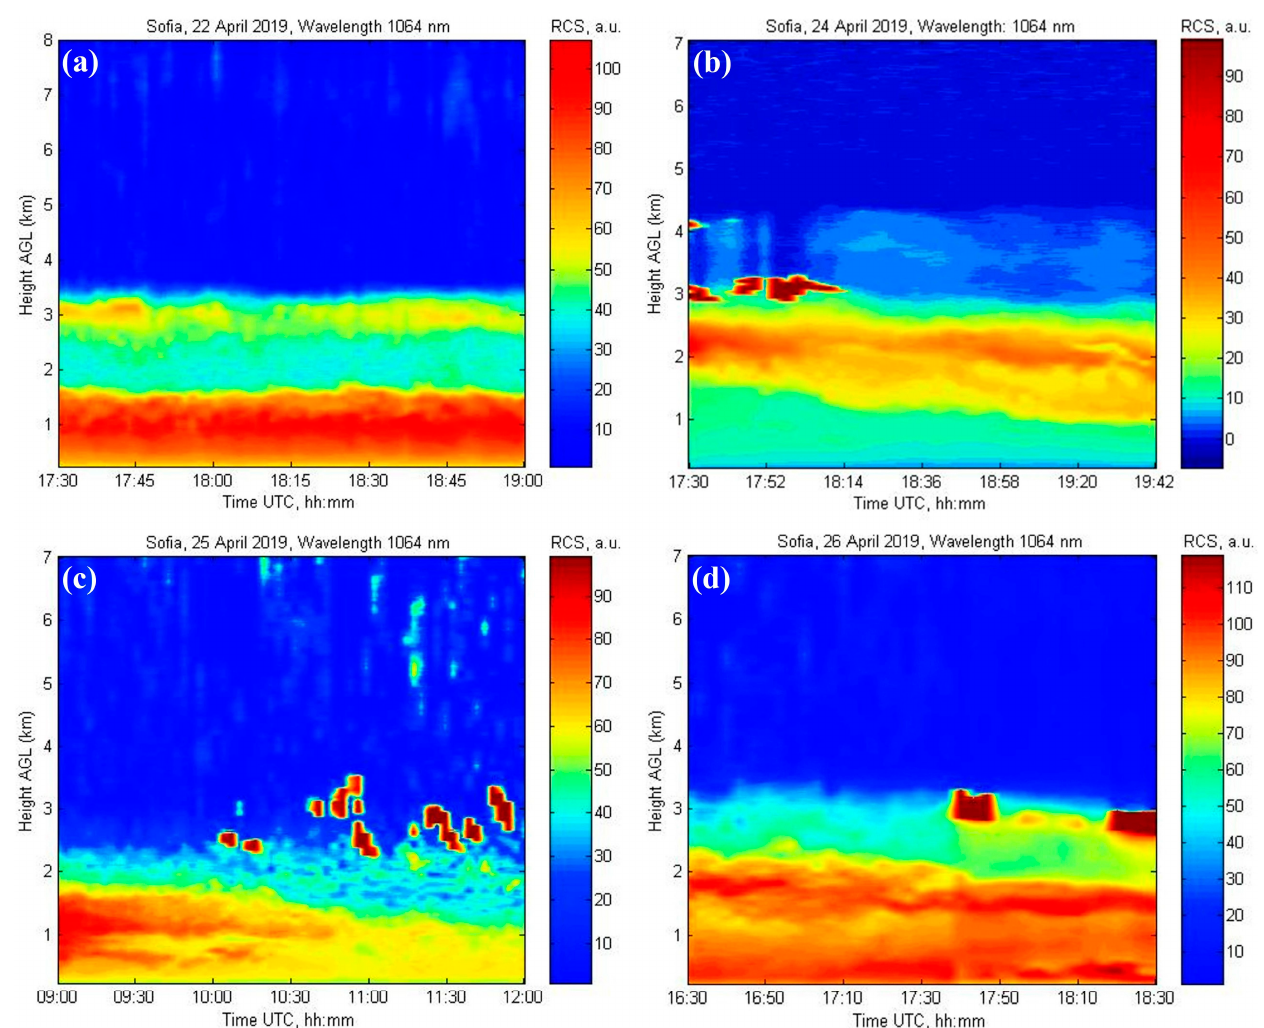
Figure 7. Color-coded time series of range-corrected lidar signals measured at 1064 nm on ( a ) 22 April 2019, ( b ) 24 April 2019, ( c ) 25 April 2019, and ( d ) 26 April 2019.